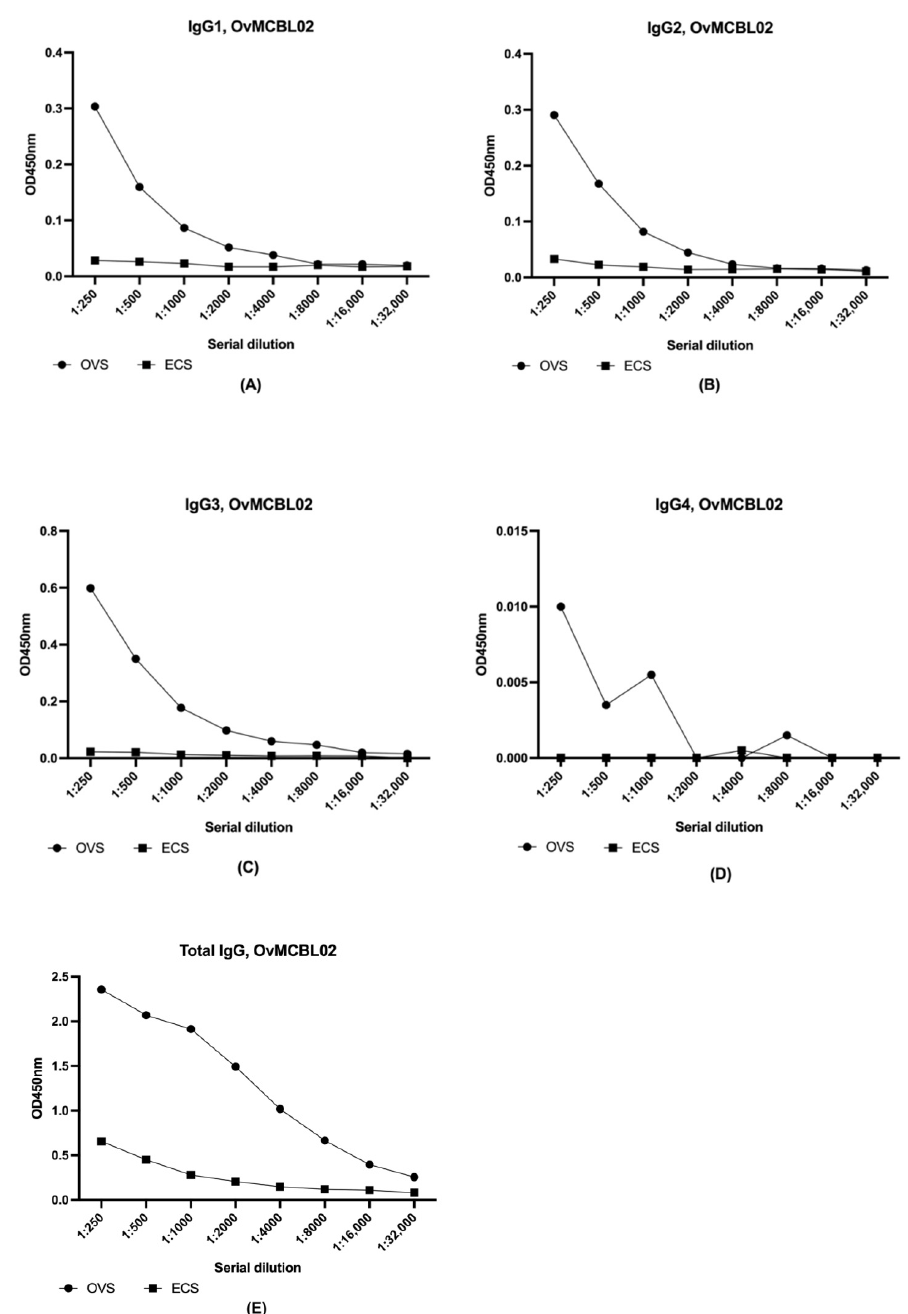
Figure 5. Measurement of IgG subclasses and total IgG response to OvMCBL02 multiepitope antigen using sera pools from infected (OVS, n = pool of 10 infected serum samples) and non-infected individuals (ESC, n = pool of 10 control serum samples). Microtiter plates were coated with purified antigen for 2 h and blocking was performed overnight. Plates were incubated with serum pools from either OVS or ECS at different dilutions (1:250 to 1:32,000) followed by incubation with ( A ) anti-human IgG1 (Fc-specific) antibody ( B ), mouse monoclonal anti-Human IgG2, ( C ) mouse monoclonal anti-Human IgG3, ( D ) mouse monoclonal anti-Human IgG (HRP), or ( E ) goat anti-human IgG peroxidase conjugate as the secondary antibody. TMB was used for revelation and optical densities read at 450 nm. OD values were plotted against the different serum types.